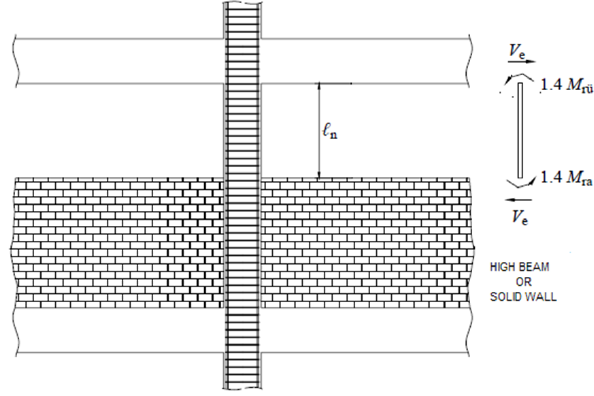
Figure 5. TEC 2007 (TEC,